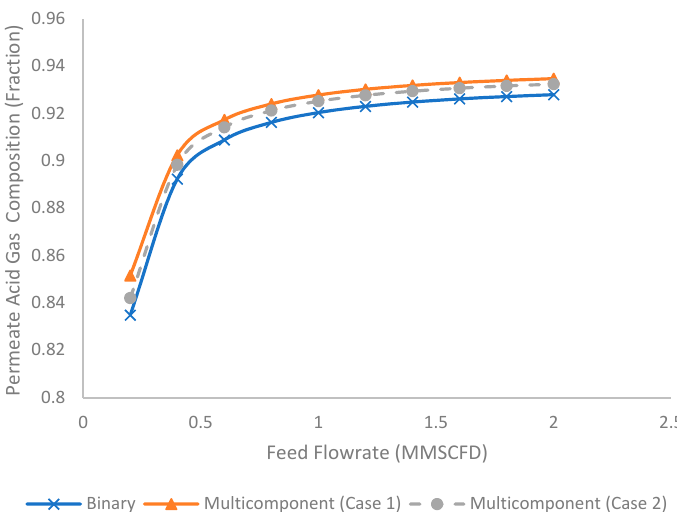
Figure 12. Evolution of permeate acid gas composition under different feed flow rates for binary and multicomponent systems.